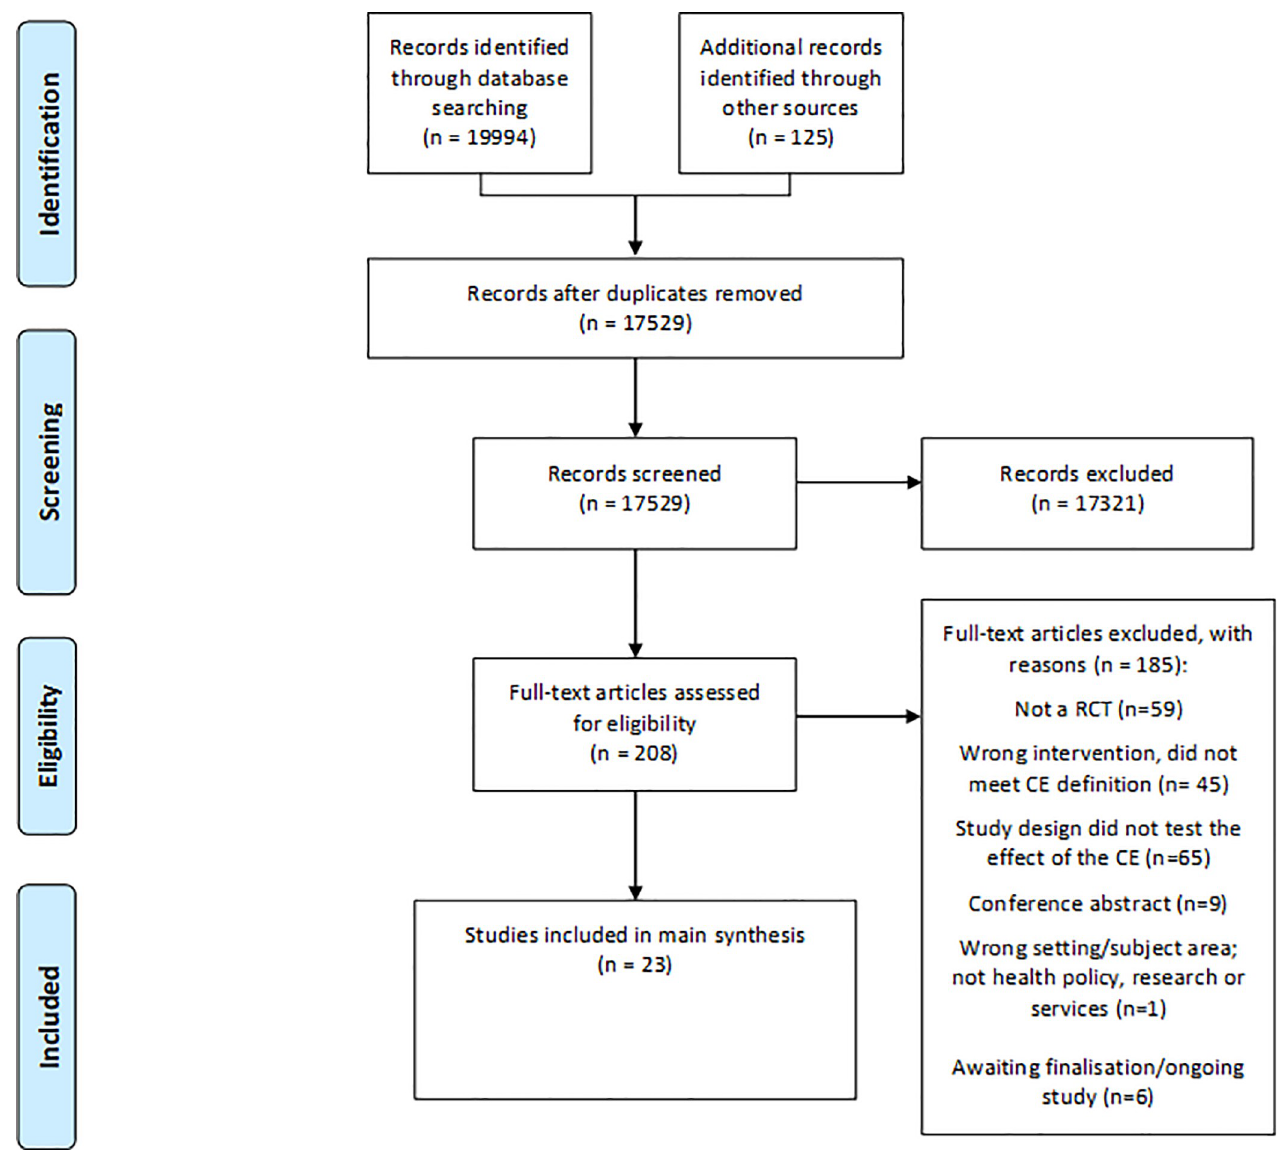
Fig 1. Modified PRISMA flowchart outlining the search results